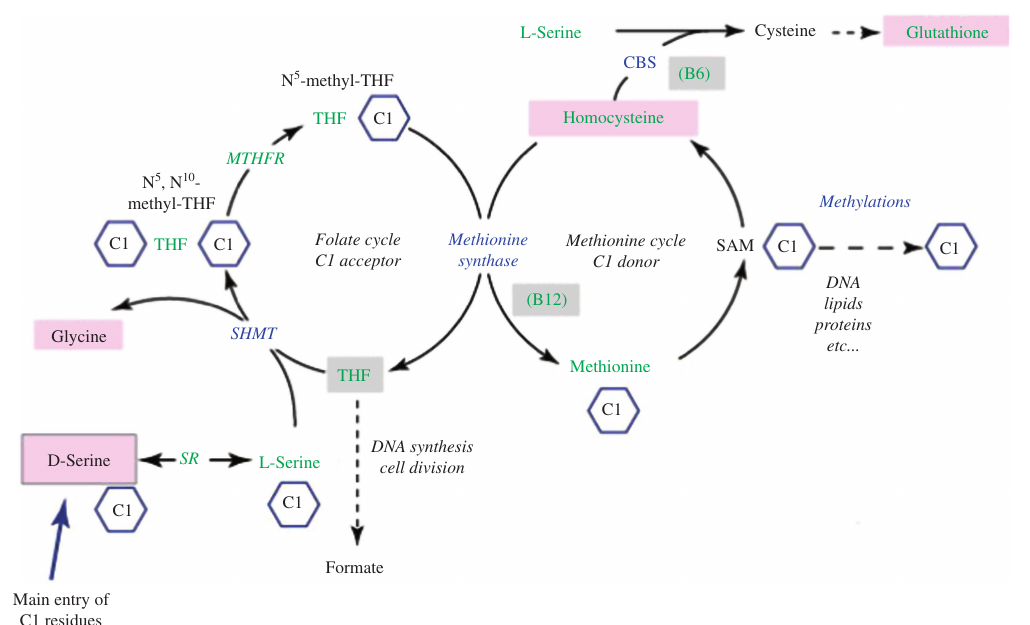
Figure 5 Folate functions as a single carbon donor in the synthesis of glycine from serine in folate cycle. B6, pyridoxal’5-phosphate; B12, cobalamin; BHMT, betaine homocysteine methyltransferase; CBS, cystathione β synthase; MTHFR, 5, 10-methylene-THF reductase; N5-methyl-THF, N5-methyltetrafolate; SAM, S-adenosylmethionine; THF, tetrahydrofolate [179 –